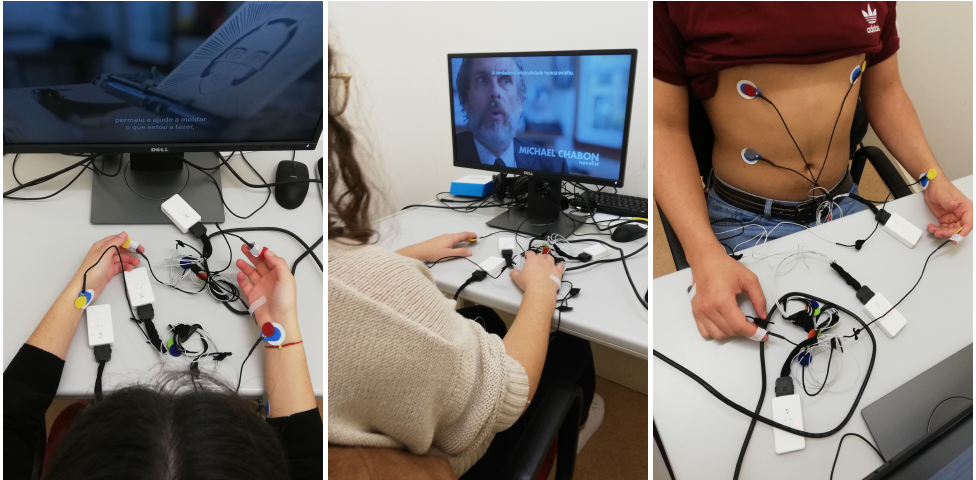
Figure 1. Example of electrode placement on both hands, wrists and